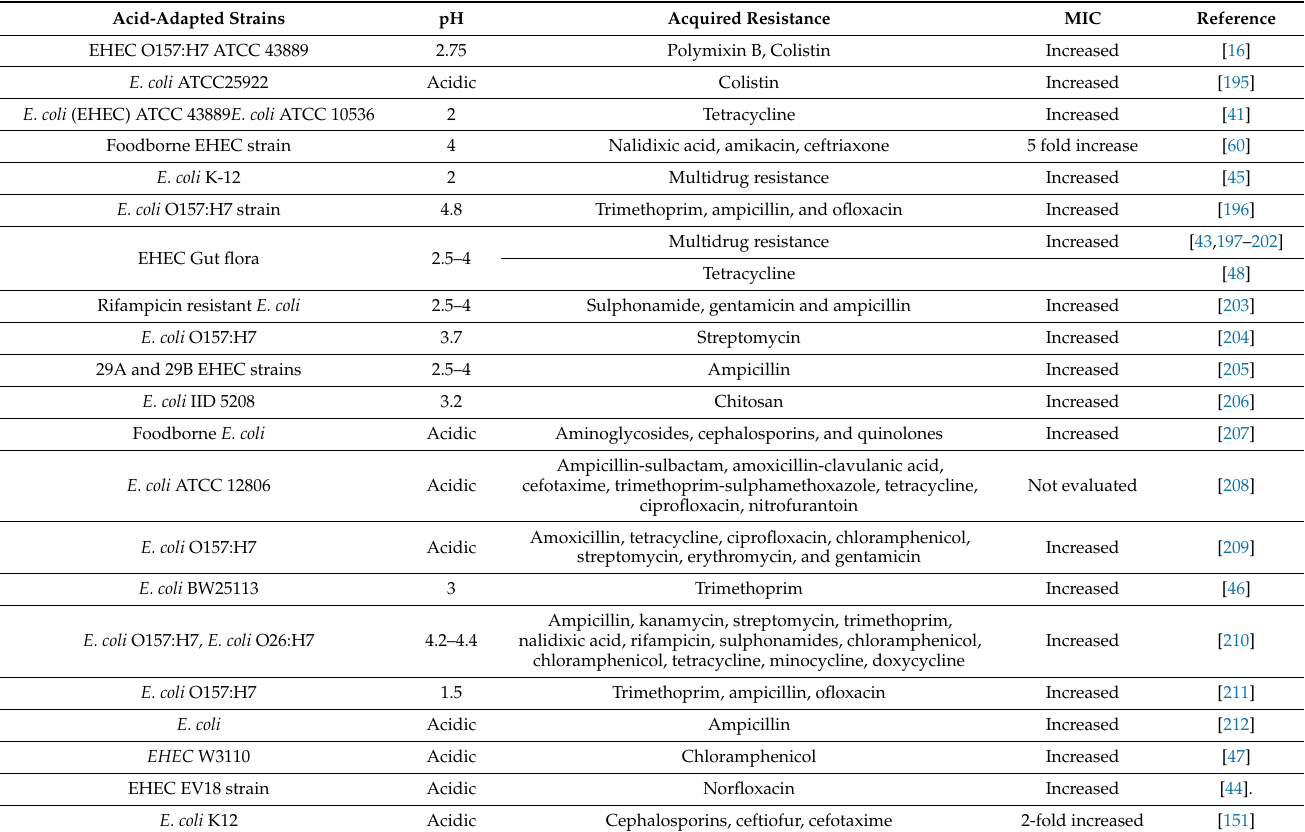
Table 4. Effect of low pH-mediated cross-protection against antibiotics and minimum inhibitory concentrations (MIC) of different EHEC